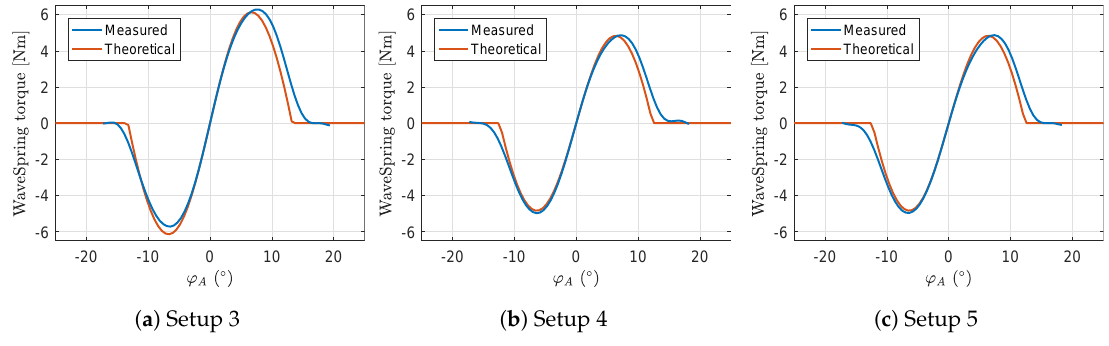
Figure 9. Theoretical and measured values for τ WS as a function of the rotation about pivot A for the different setups equipped with the WaveSpring